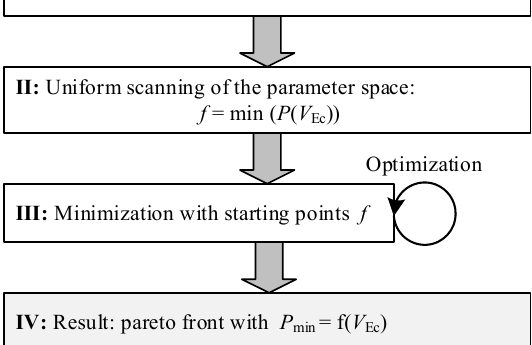
Table 7. Tuning parameters for a loss-optimized design of the hf transformer and resonance inductor.